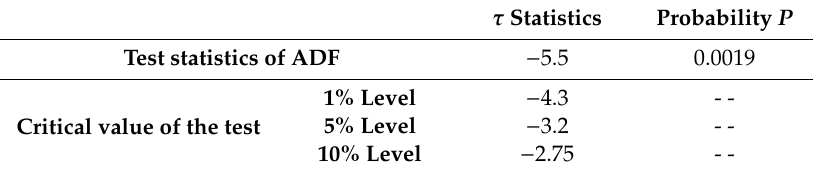
Figure 15. Autocorrelation coefficient and partial autocorrelation coefficient of casing pressure time series. Table 7. Unit root test results of the casing pressure time series after the first-order di ff erence.